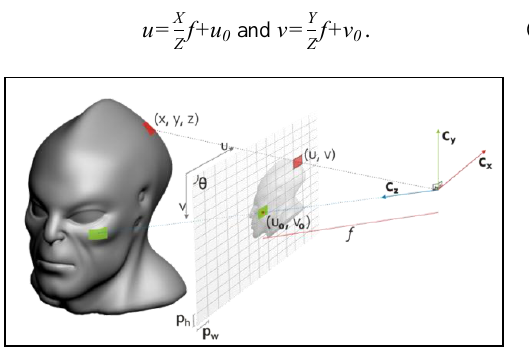
Figure 2. Perspective transform from 3D points to image points. However, the image plane is divided in pixels units that correspond in the real world to well defined areas with dimensions written in millimeters. They are, by default, called pixel width ( ) and pixel height ( ) 1 . Considering that, the dimensions of u and v are not written in millimeters but in pixels, and by this the equation (1) must be rewritten as